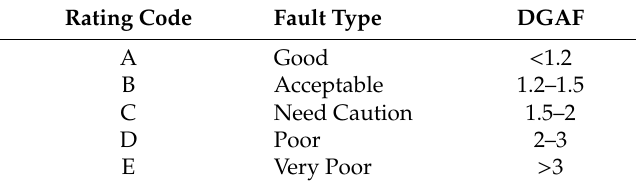
Table 2. Transformer rating based on Dissolved Gas Analysis (DGA) factor [10].